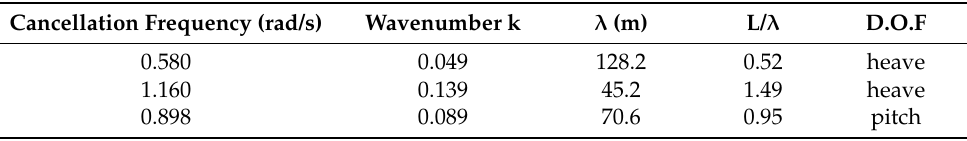
Table 3. Cancellation frequencies identified from the motion RAOs of the barge frame in 0 deg incident wave